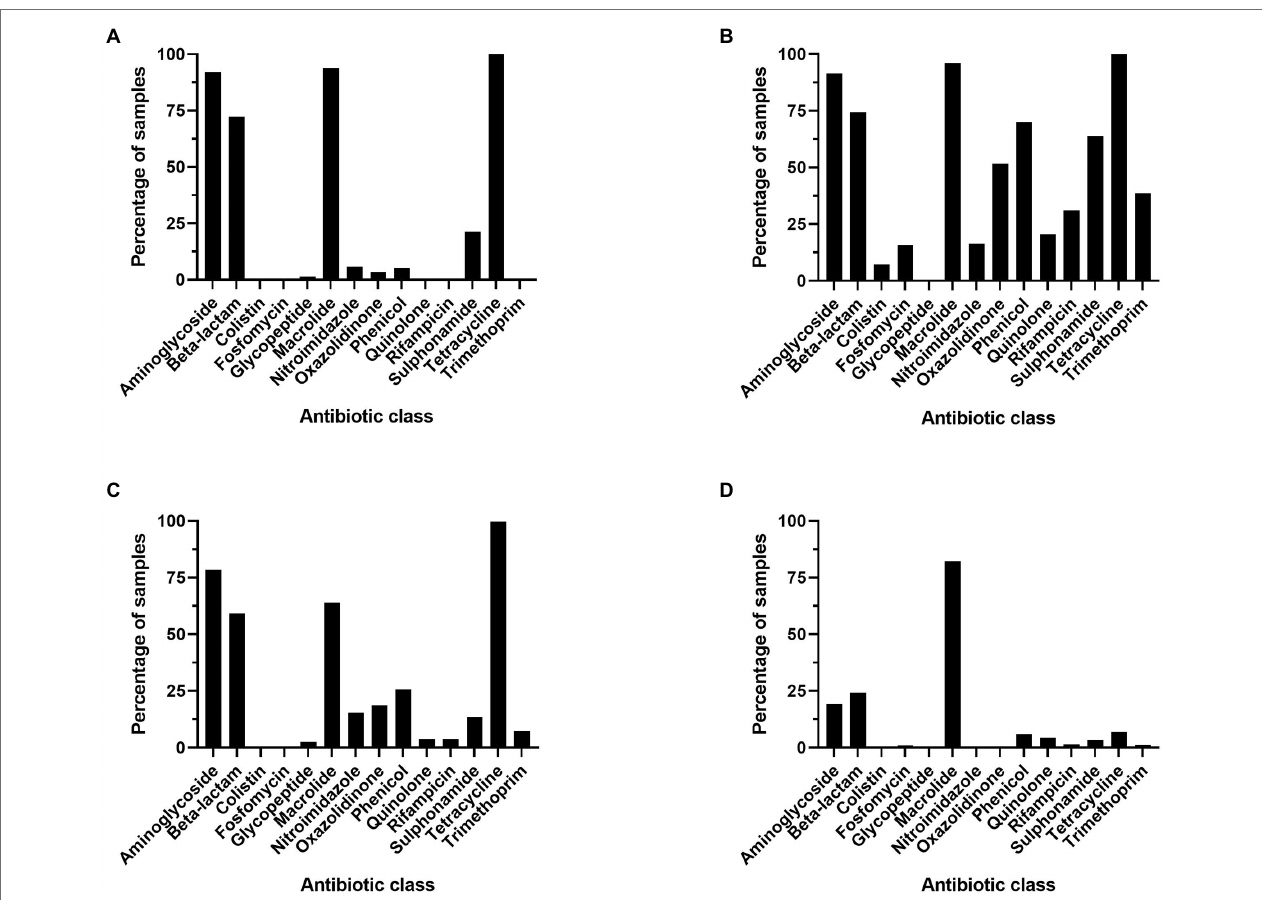
FIGURE 4 | Percentage of metagenomes that contain at least one resistance gene per antibiotic class, genes were considered present if occurring >25 times in a sample. (A) Ruminant, (B) poultry, (C) swine, and (D)